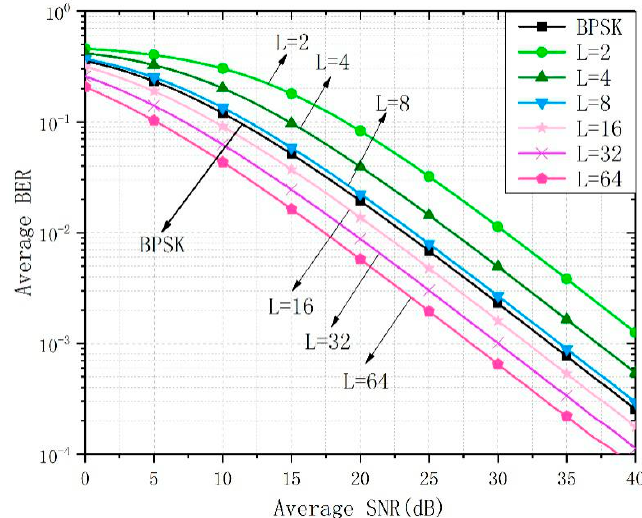
Figure 4. Average BER of L-ary pulse position modulation (LPPM) and BPSK against average SNR per hop under strong turbulence and the pointing error parameter is ξ = 1. Turbulence parameters are α = 4.2 and β = 1.4, the constant is assumed to be C = 1.